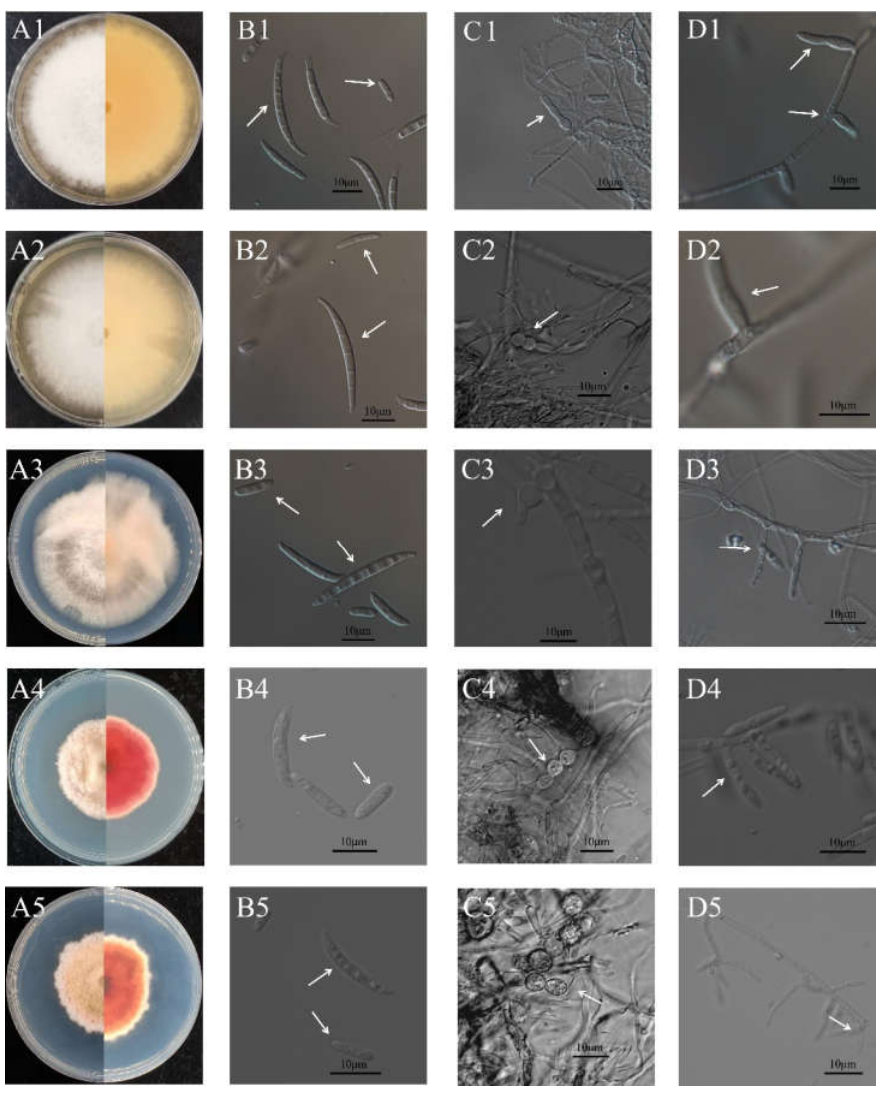
Figure 2. Morphological characteristics of pathogens. ( A ) The front (left) and back (right) of a colony; ( B ) macroconidia and microconidia; ( C ) chlamydospores; ( D ) conidiophores. B, C and D are indicated by arrows. Numbers 1, 2, 3, 4, and 5 correspond to HHAUF210507, HHAUF210509,